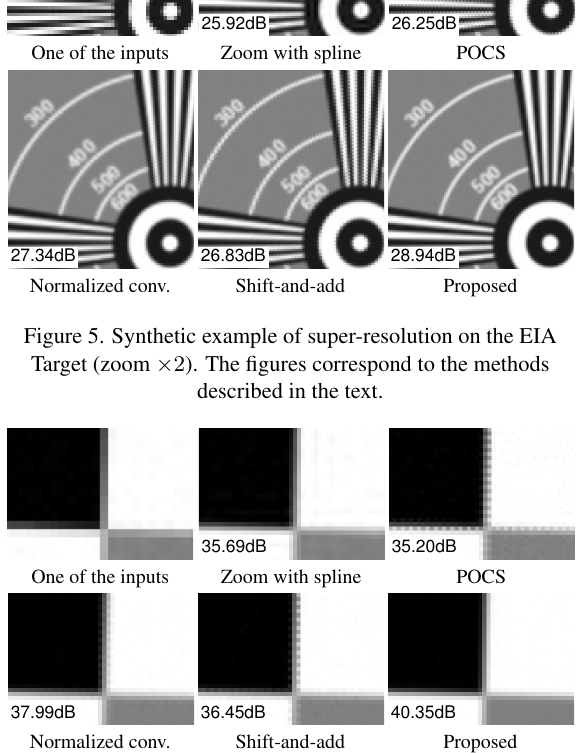
Figure 8. We evaluate the quality of the proposed method on real Figure 6. Super-resolution of a synthetic slanted-edge target for data using this target located in Baotou, China. The regions estimating the MTF (zoom × 2 ). The MTFs estimated on this indicated by the four colors are used to estimate the SNR in the example are presented in Figure 7. The figures correspond to the reconstructed images. The SNR is estimated independently for methods described in the text. each region and is reported in Table